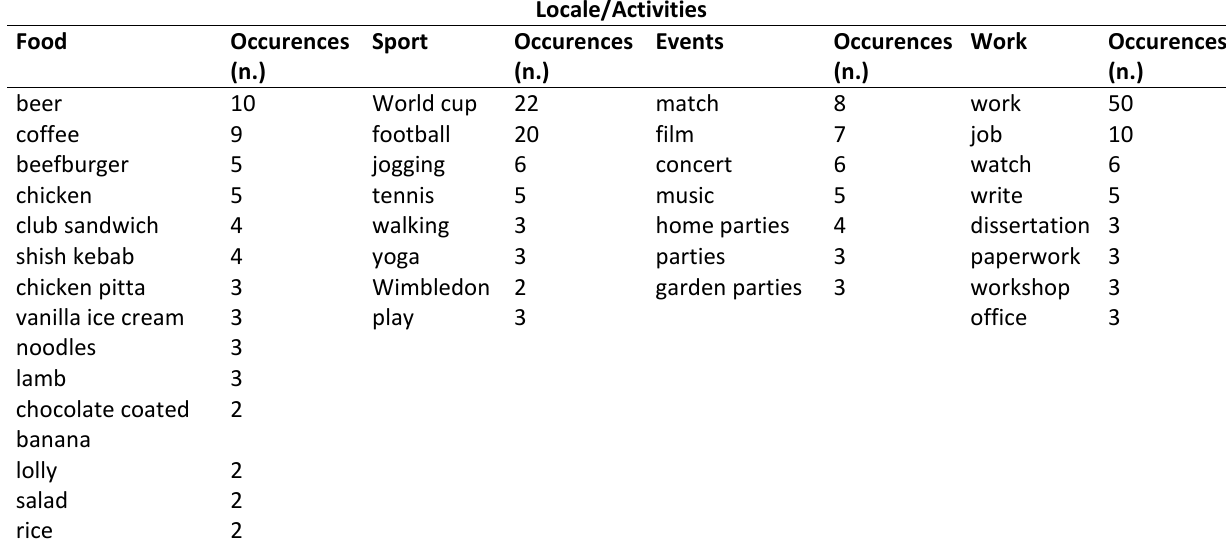
Locale/Activities